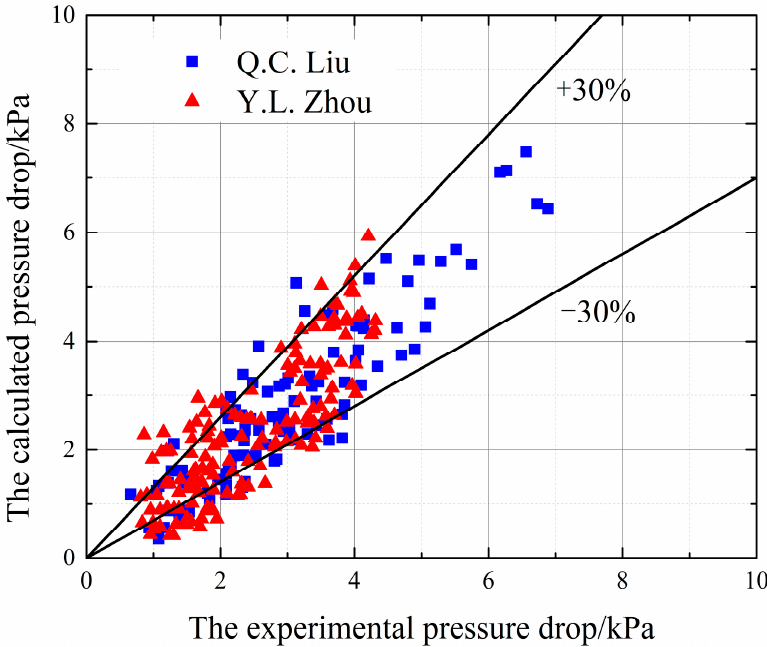
Figure 15. The comparison between the calculated values of developed correlation and the experi- mental values.